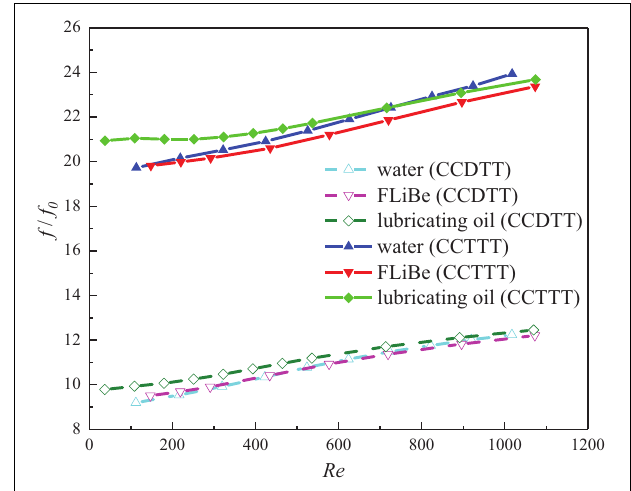
FIGURE 9 | Temperature profile of different fluids in the tube fitted with CCDTT ( y = 3) at l = 0.24 m, Re = 720.